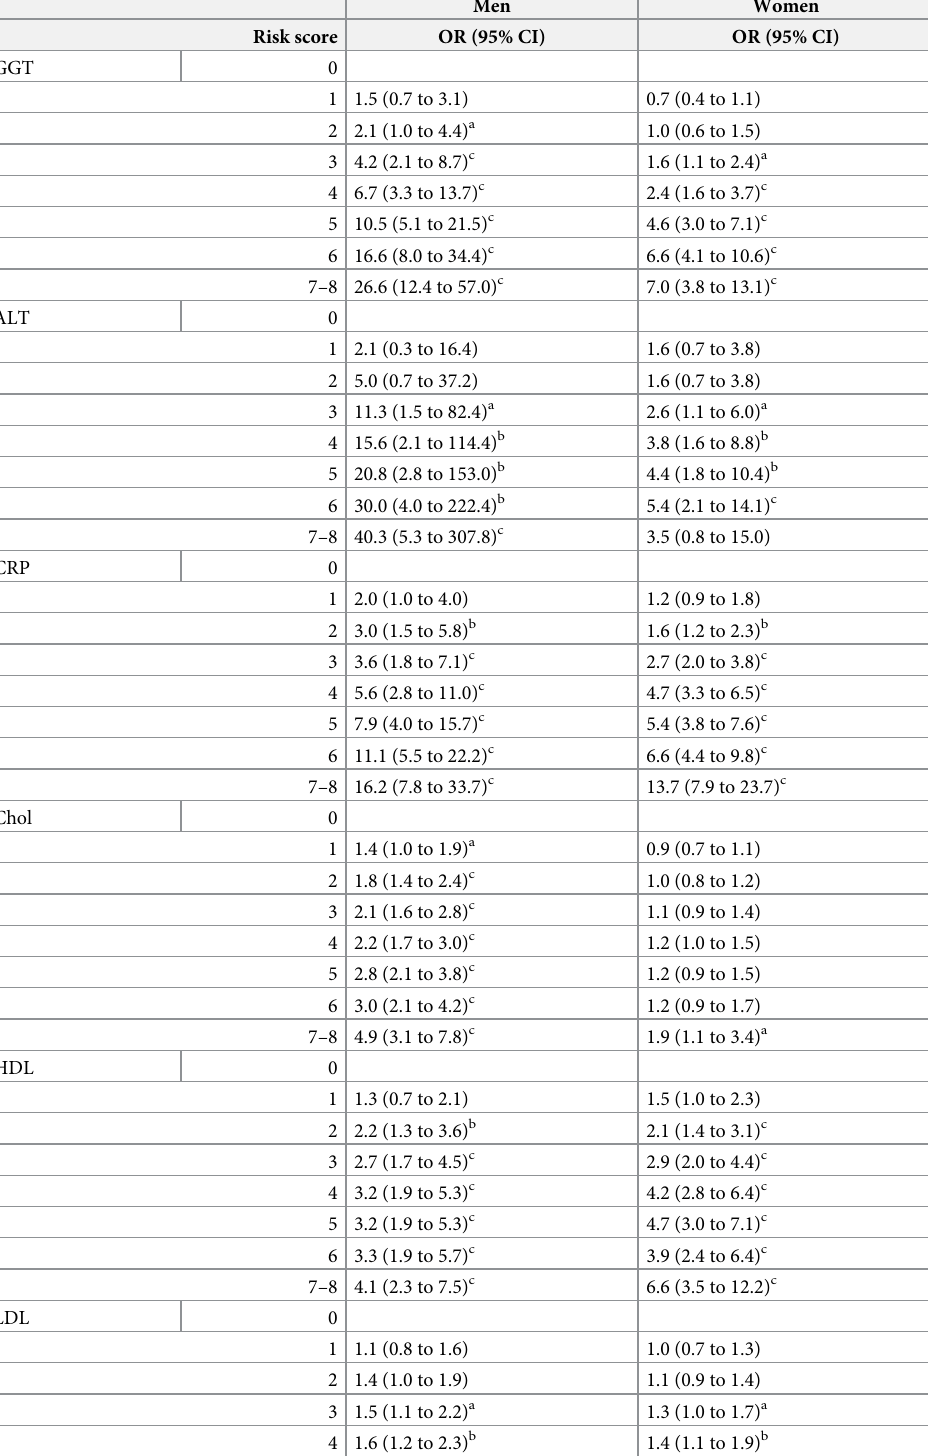
Table 3. Odds ratios (ORs) for abnormal biomarker status according to individual lifestyle risk factor scores, as adjusted for age and coffee